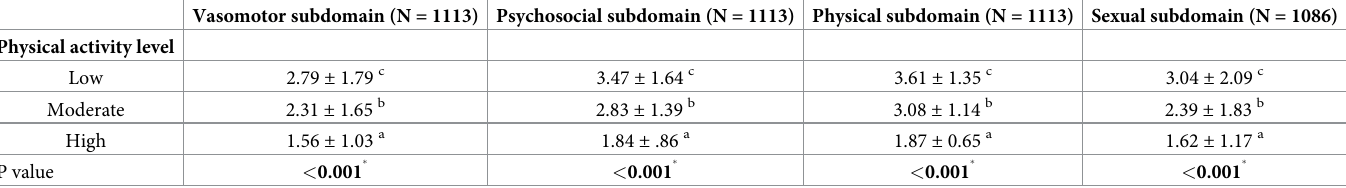
Table 5. Mean scores of MENQOL subdomains according to physical activity level of participants.